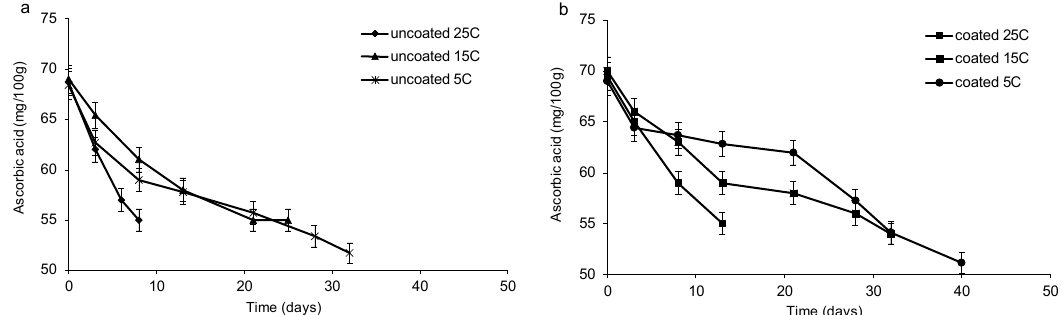
Figure 6. Changes in ascorbic acid content of ( a ) uncoated and ( b ) coated limes during storage at different temperatures.